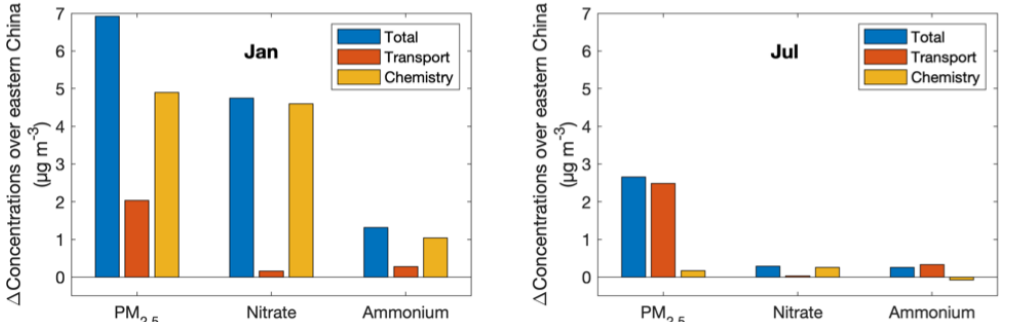
Figure 5. Foreign anthropogenic contributions to PM 2 . 5 , nitrate, and ammonium concentrations in January and July over eastern China. Total concentration contributions of foreign anthropogenic emissions are split into contributions from direct transport and chemical interactions according to the legend. The contributions to other PM 2 . 5 components are shown in Fig.